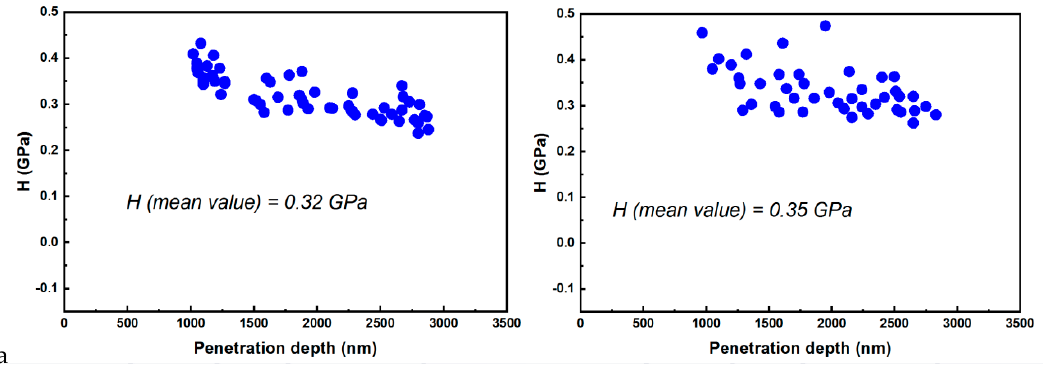
Figure 13. Hardness versus penetration depth for ( a ) E-Dent 100 and ( b ) the newly obtained composite with 0.4% nanoTiO 2.